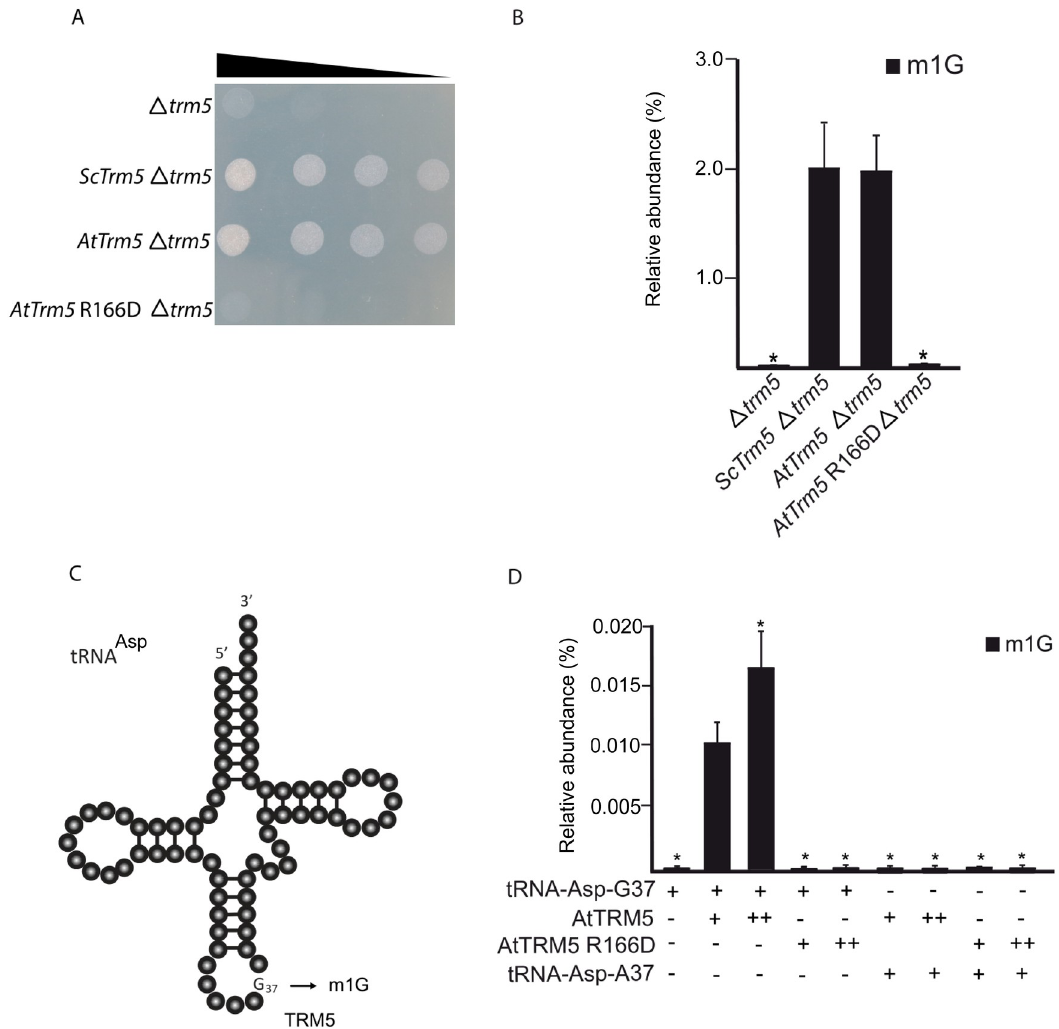
Fig 4. TRM5 modifies tRNA 37 guanosine (G) to m 1 G in yeast. ( A ) Serial-dilution growth assay. Complementation experiment of TRM5 from yeast (Sc), Arabidopsis thaliana (At) or a catalytically inactive mutant AtTrm5 R166D in the yeast trm5 mutant. ( B ) Relative nucleoside level of modification m 1 G quantified by HPLC/MS of each complemented yeast strains with either ScTRM5 or AtTRM5. ( C ) Proposed model of TRM5-mediated m 1 G modification of yeast tRNA-Asp. ( D ) Relative nucleoside level of modification m 1 G with varying conditions of tRNA-Asp-G37, AtTRM5, AtTRM5 catalytic mutant, and tRNA-Asp-A37. + indicates presence, ++ indicates two-fold increase,—indicates